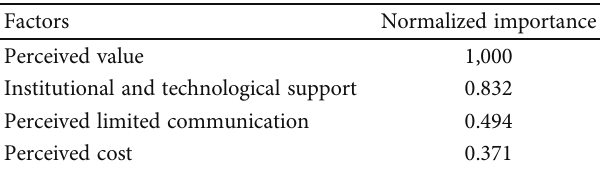
Table 8: The importance of variables in determining the changes in independent